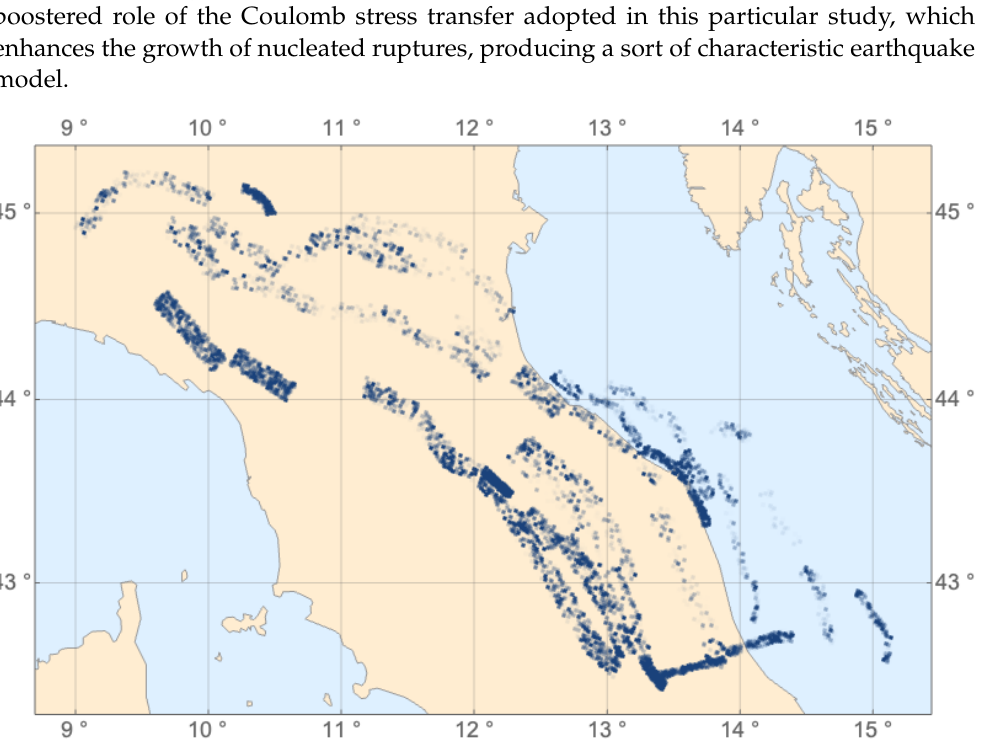
Figure 3. Map of 13,845 simulated earthquakes with M w ≥ 5.0, obtained from 100,000 years simula- tion. Point opacity is proportional to number of epicenters reported in output synthetic catalog in each cell of